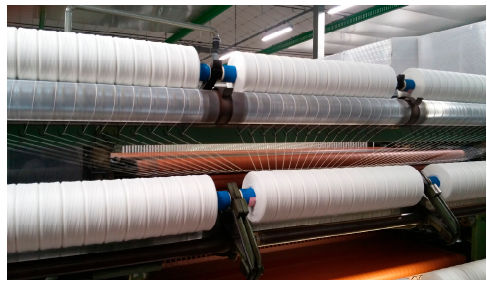
Figure 4. Untwisted yarn obtained by the tow, wrapped in spools.